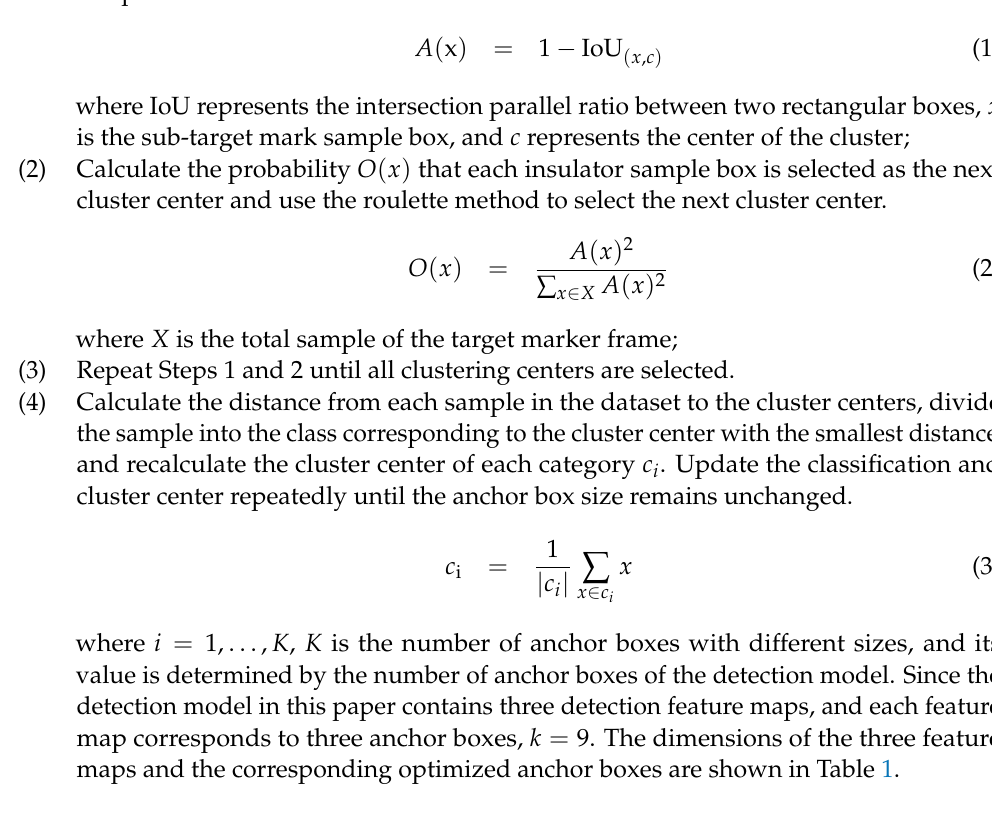
Table 1. Optimized anchor box parameters. Feature Map